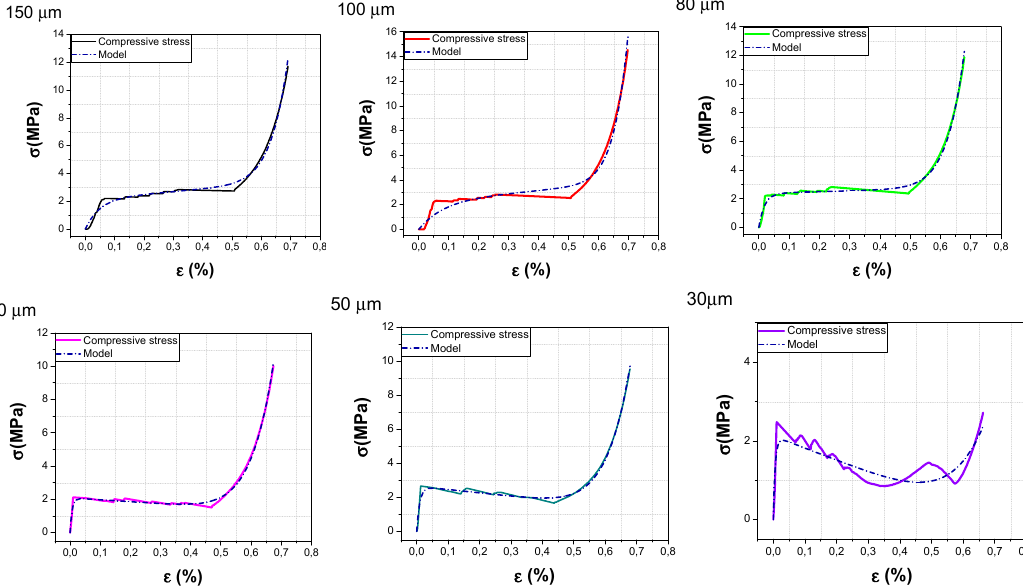
Figure 10. Measured and fitting curves for stress–strain curves for pristine CNT pillars with diameters ranging from 150 µm to 30 µm.